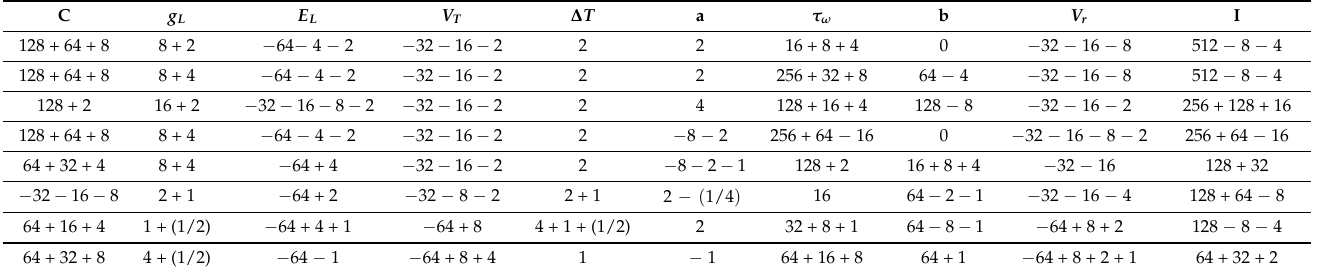
Table 4. ADEX digital parameters using in hardware implementation (based on the spiking patterns of Table 1).